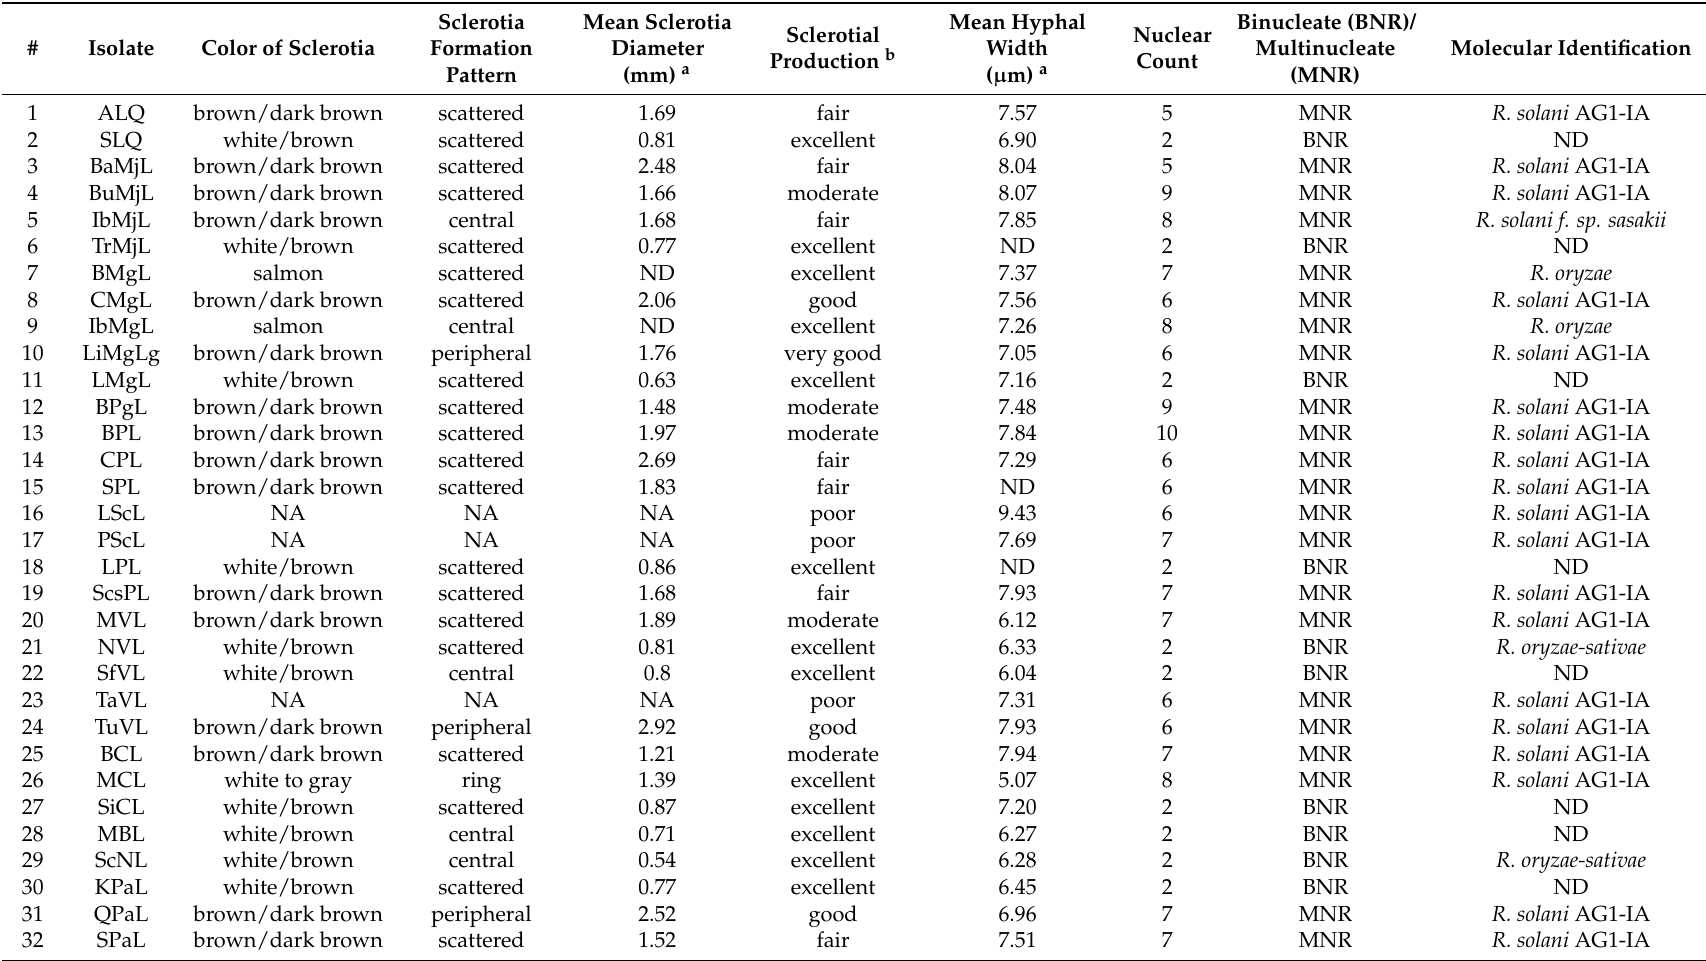
Table 2. Sclerotial and microscopic characteristics of different Rhizoctonia isolates collected from rice-producing areas in Laguna,